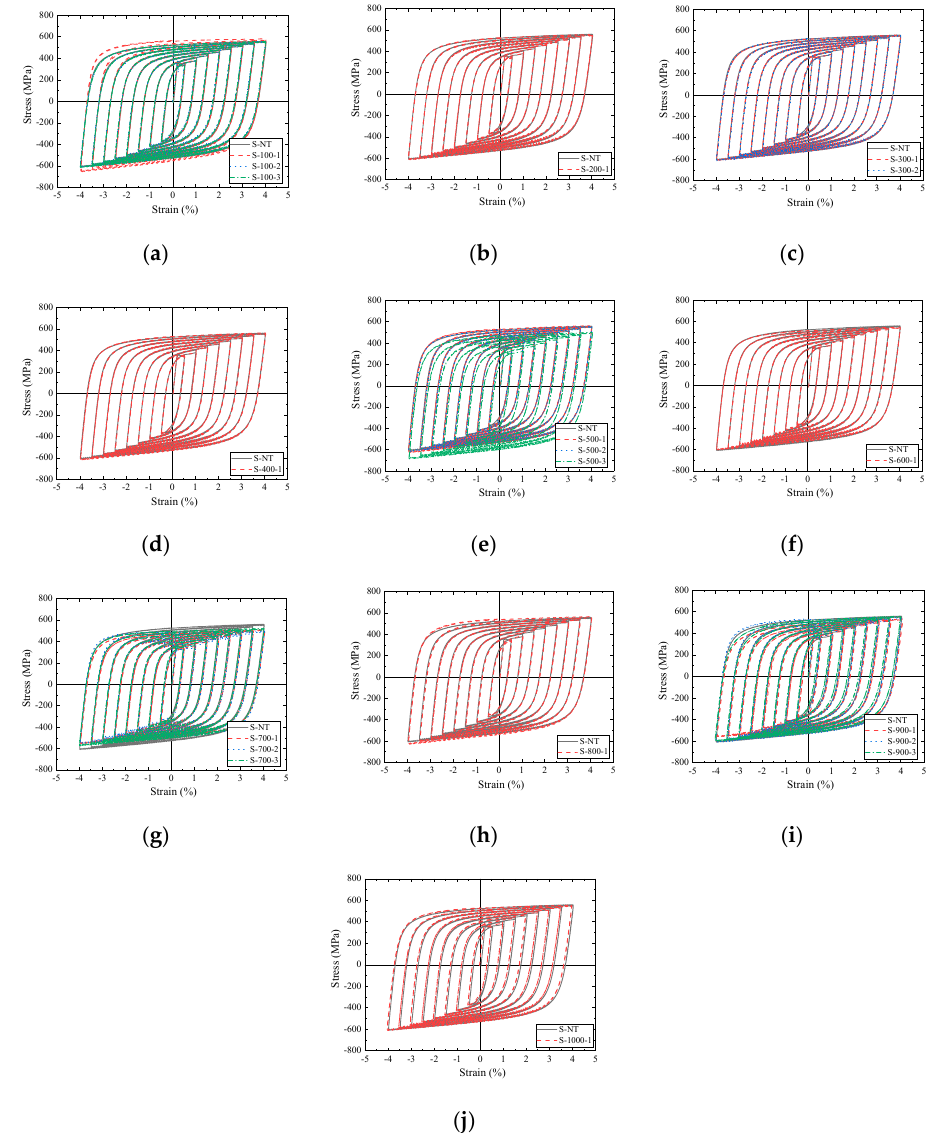
Figure 12. Hysteretic curves of Q345. ( a ) 100 °C; ( b ) 200 °C; ( c ) 300 °C; ( d ) 400 °C; ( e ) 500 °C; ( f ) 600 °C; ( g ) 700 °C; ( h ) 800 °C; ( i ) 900 °C; ( j ) 1000 °C.